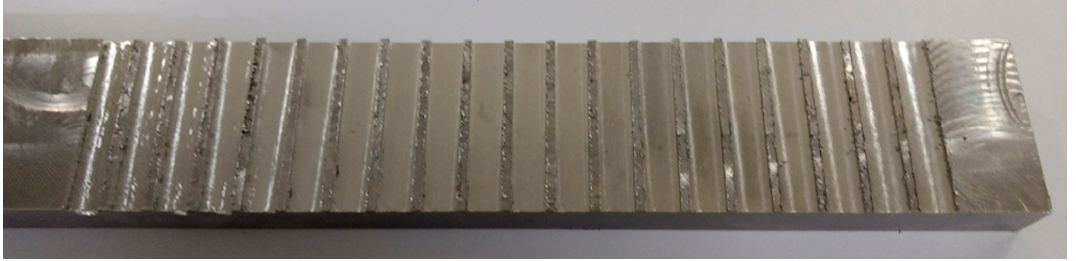
Figure 2. Ti-6AL-4V bar after machining. Table 1. Chemical composition of Ti-6Al-4V (provided by VINER Brasil Tecnologia Ltda., Sao Paulo, Brazil).